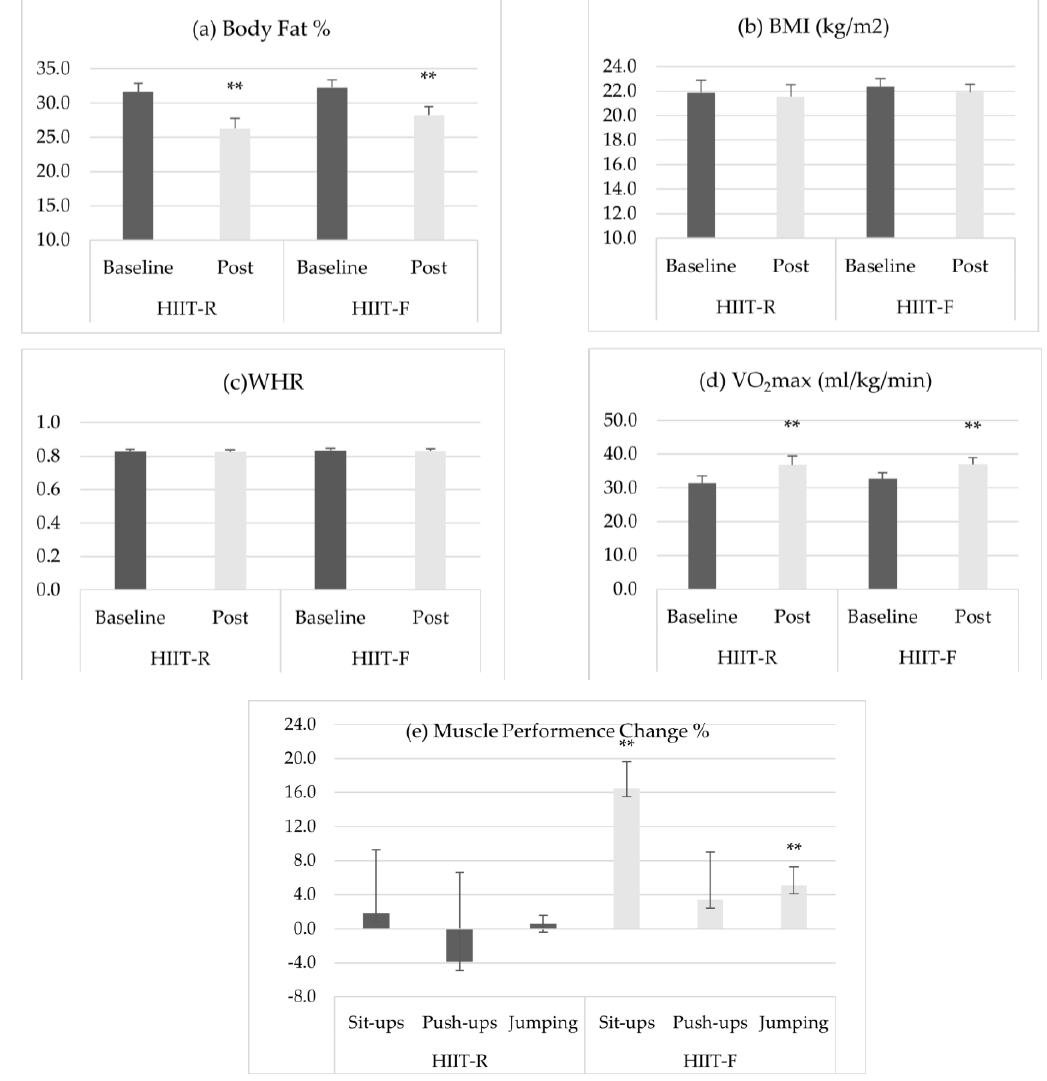
Figure 1. Changes in ( a ) BMI, ( b ) body fat%, ( c ) WHR, ( d ) VO2max, and ( e ) muscle performance change. Note: ** significantly different from baseline at p < 0.01. Table 3. Body composition and aerobic capacity data from HIIT-R and HIIT-F groups.